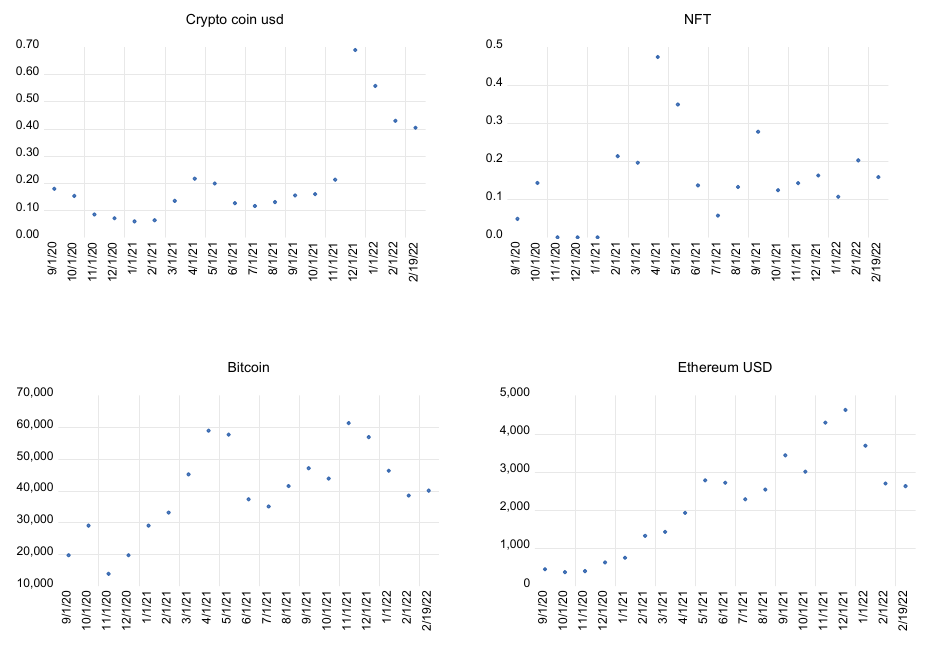
Figure 2. Variables trend. Table 2. Summary Statistics of Dependent and Explanatory